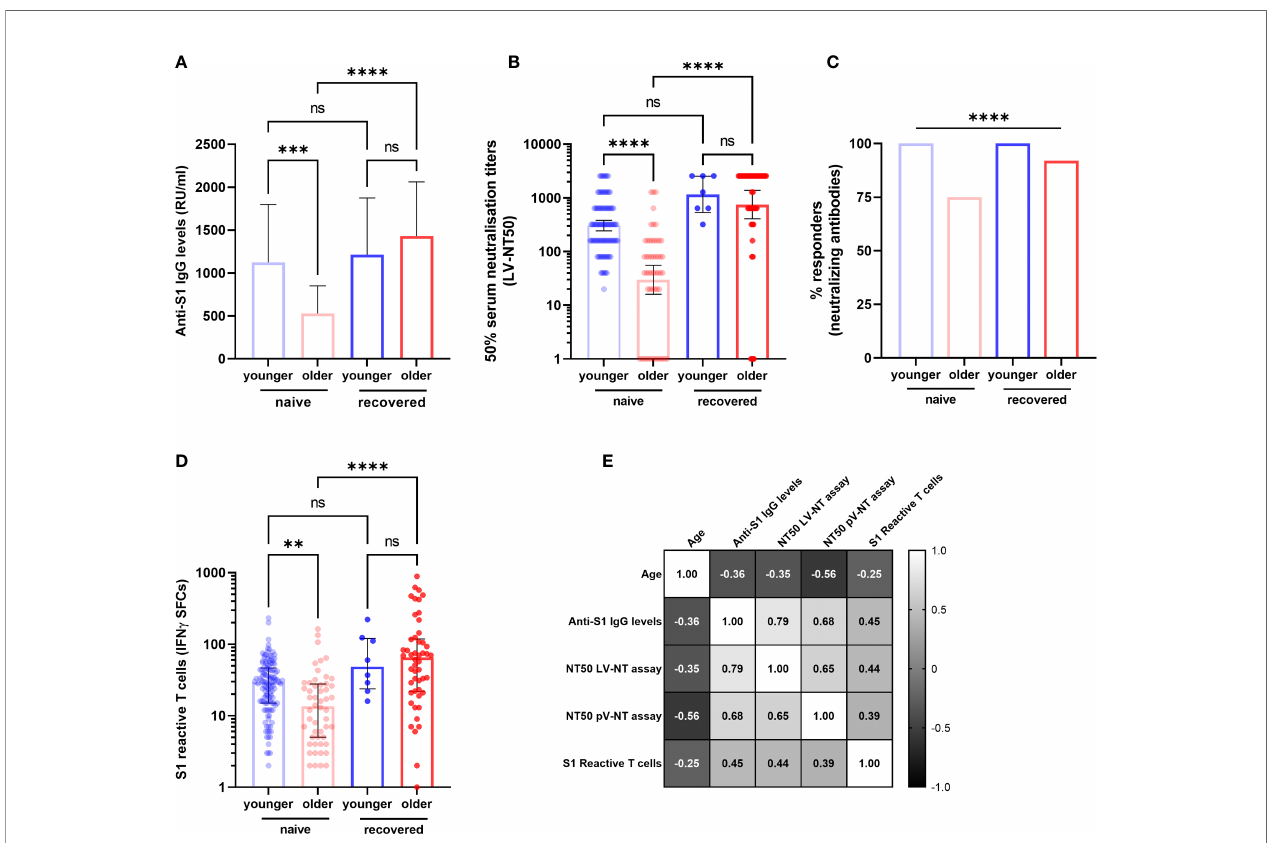
FIGURE 3 | Speci fi c antibody and T-cell responses in older and in young adults 3 months after the fi rst injection of BNT162b2. (A) Antibody responses assessed by ELISA (anti-S1 IgG) (COVID-19-naive younger n = 121, COVID-19-naive older n = 54, COVID-19-recovered young n = 8, COVID-19-recovered older n = 47; median [interquartile range (IQR)] are shown). (B) Serum neutralization assay against live virus (COVID-19-naive young adults n = 101, COVID-19-naive older n = 52, COVID-19-recovered young n = 7, COVID-19-recovered older n = 51; geometric median and 95% con fi dence interval are shown). (C) Participants with detectable neutralizing antibodies according to live virus-neutralizing assay (titer ≥ 1:20). (D) Number of S1 peptide pool reactive T cells (ELISpot) (COVID-19-naive young adults n = 121, COVID-19-naive older n = 52, COVID- 19-recovered young n = 8, COVID-19-recovered older n = 50; median [interquartile range (IQR)] are shown). (E) Correlations between age and main immune parameters of the postvaccinal response at 3 months in COVID-19-naive older and COVID-19-naive young adults. Values are Spearman ’ s rank correlation (r) coef fi cients. The number of pairs that were analyzed, p -values and 95% con fi dence intervals of signi fi cant correlations are detailed in Table 2 . ** p -values <0.01; *** p -values < 0.001; **** p -values < 0.0001; ns, not signi fi cant. IFN g SFCs, interferon gamma spot-forming cells; LV-NT50, 50% serum neutralization titer in live virus neutralization assay; pV-NT50, 50% serum neutralization titer in pseudovirus neutralization assay.